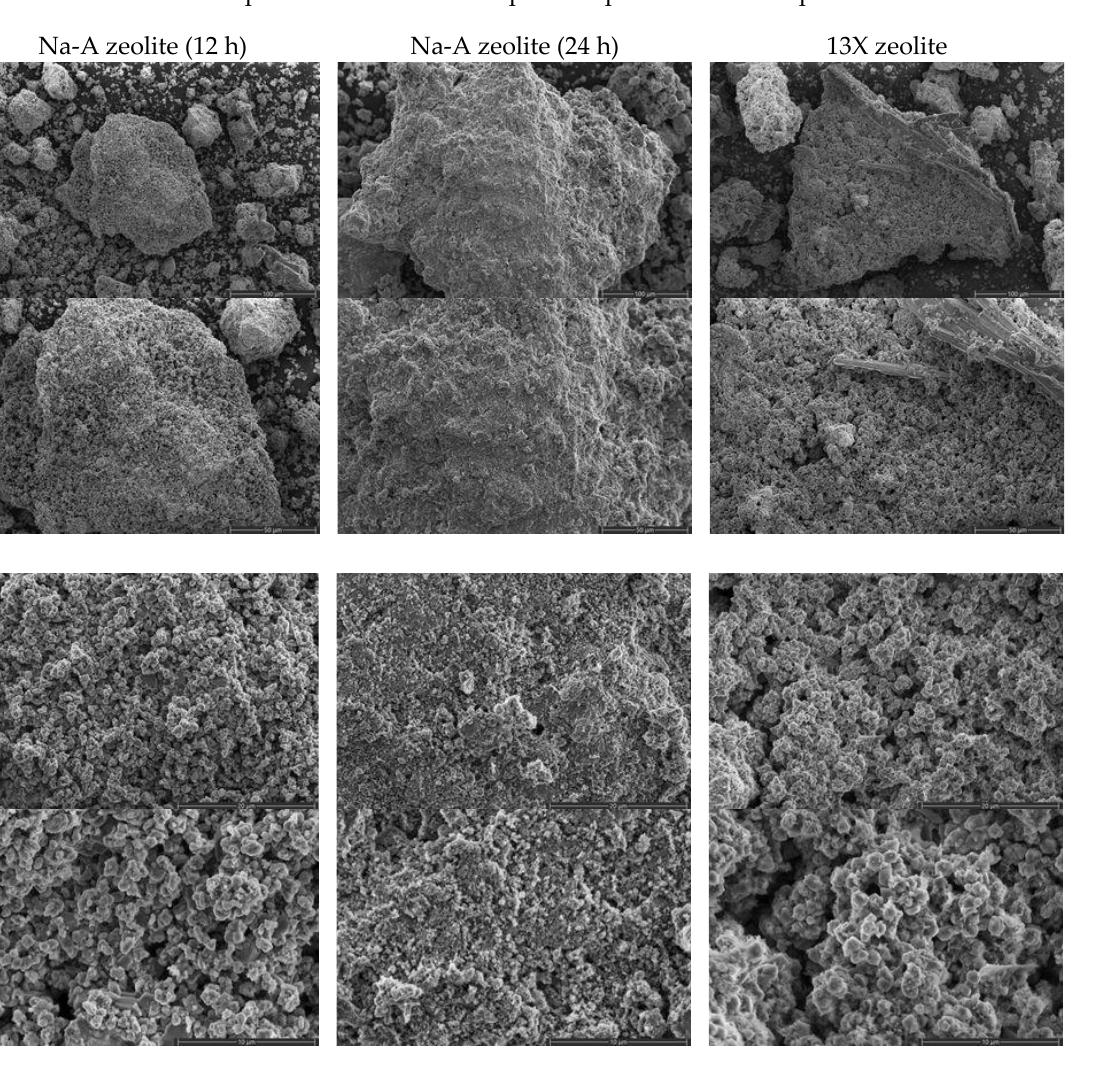
Table 1. Semi-quantitative analysis of selected components of produced zeolites. Na-A Zeolite (12 h), mol% Na-A Zeolite (24 h), mol%